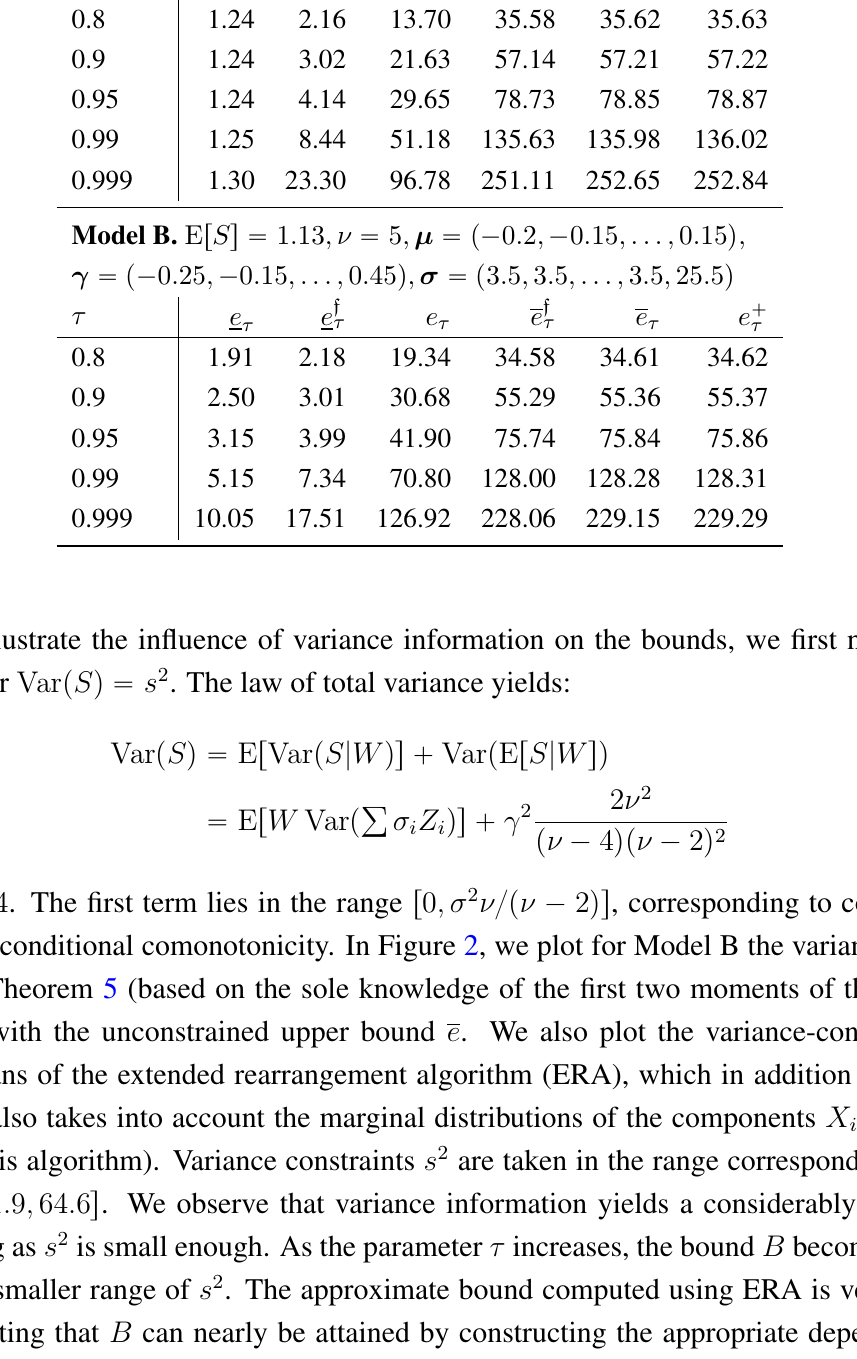
p S q for two skew- t τ